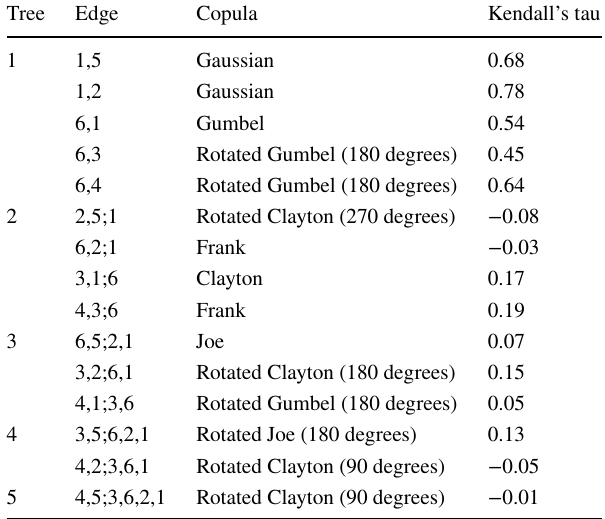
Table 4 The tree structure of the best copula Tree